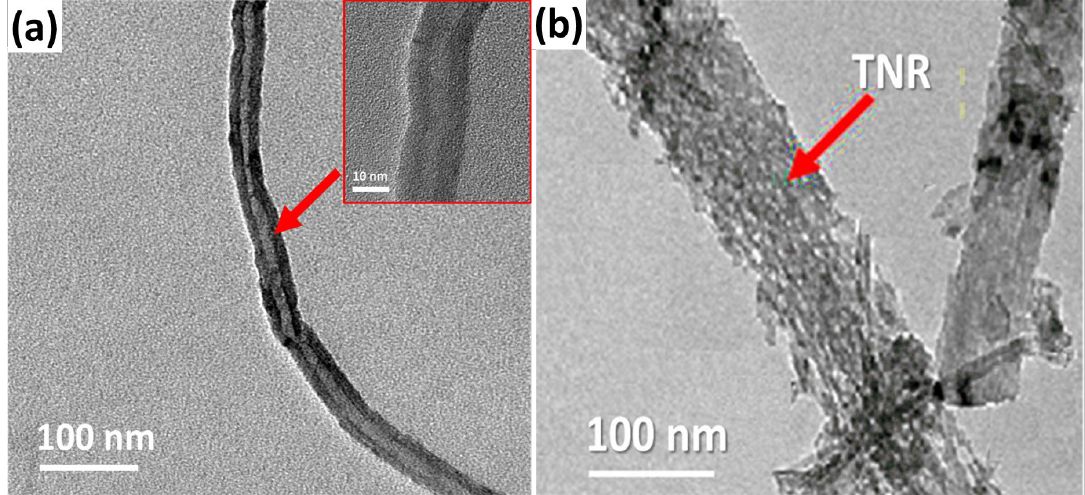
Figure 2. TEM pictures of ( a ) the CNTs and the ( b ) TNR/CNT nanocomposite.